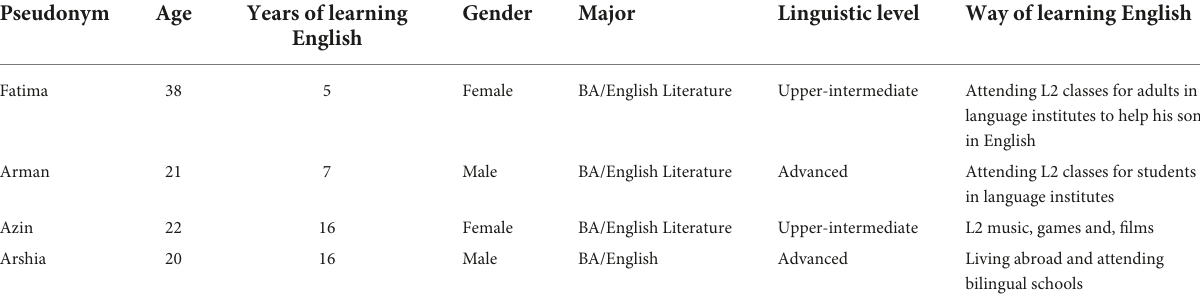
TABLE 1 Participants’ demographic